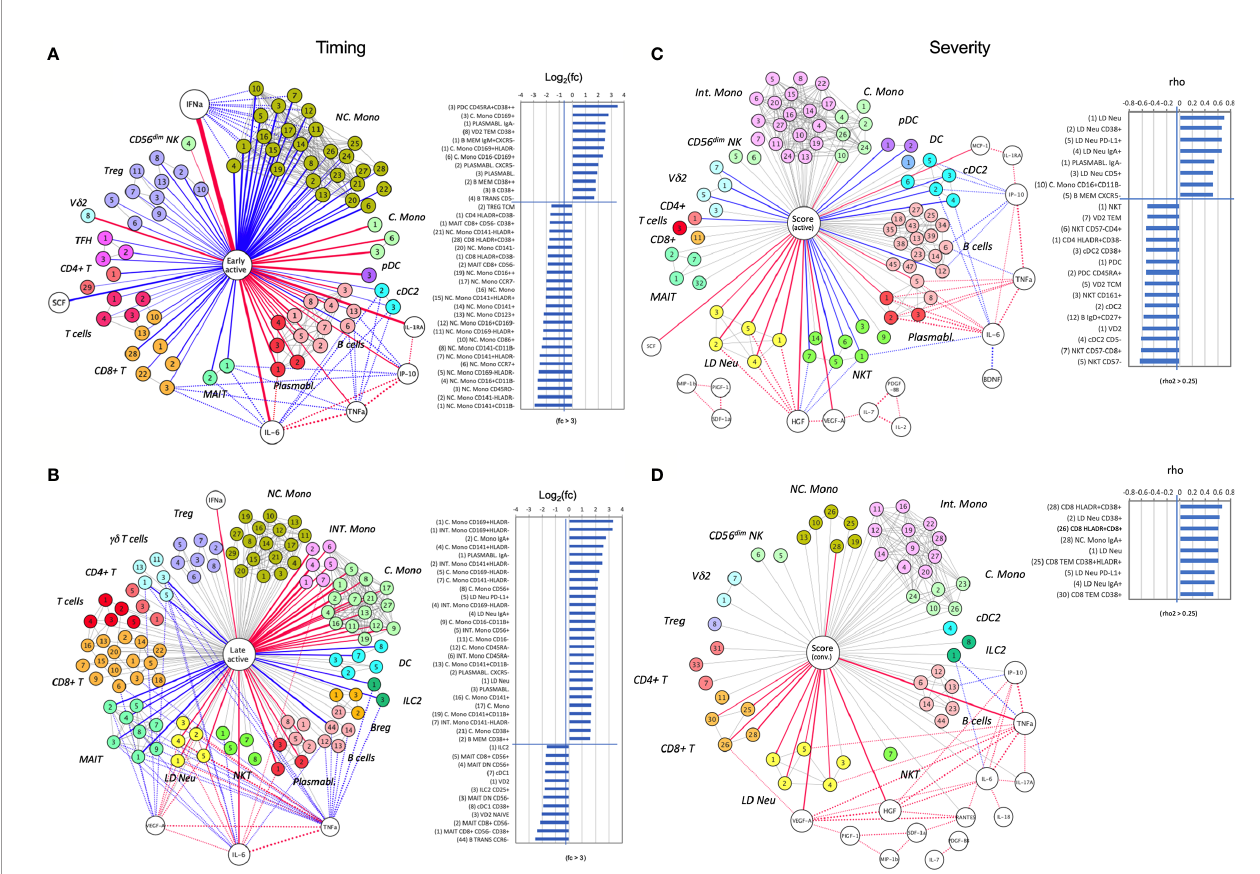
FIGURE 7 | A node-edge interaction network of the cytokine level and immune cellular frequencies in COVID-19 patients. Association are shown with regard to the timing (A, B) and the severity (C, D) . Nodes represent either cytokines (white) or immunotypes (colored). The central node represents the “ comparison of interest ” . The edges represent signi fi cant associations between two nodes with the thickness indicating the strength either based on fold change or correlation coef fi cient (rho). Color indicates the direction (Red: positive, blue: negative), dotted lines indicate associations with cytokines. For the central node, only associations with abs (rho) > 0.3 and p < 0.05 are colored and shown as bar charts on the right. For the timing (A, B) these bar charts indicate the fold changes in the early active; median day 9 PIO (A) , and late active state; median day 24 PIO (B) in reference to late convalescent state while for the severity (C, D) they represent the correlation coef fi cient (rho) in reference to the severity groups in the active (C) and convalescent state (D) . The number code of the immunotype is listed in Supplementary Table 3 , an interactive network viewer is available in the Materials and Methods: Data and Code Availability section. ++ denotes highly stained